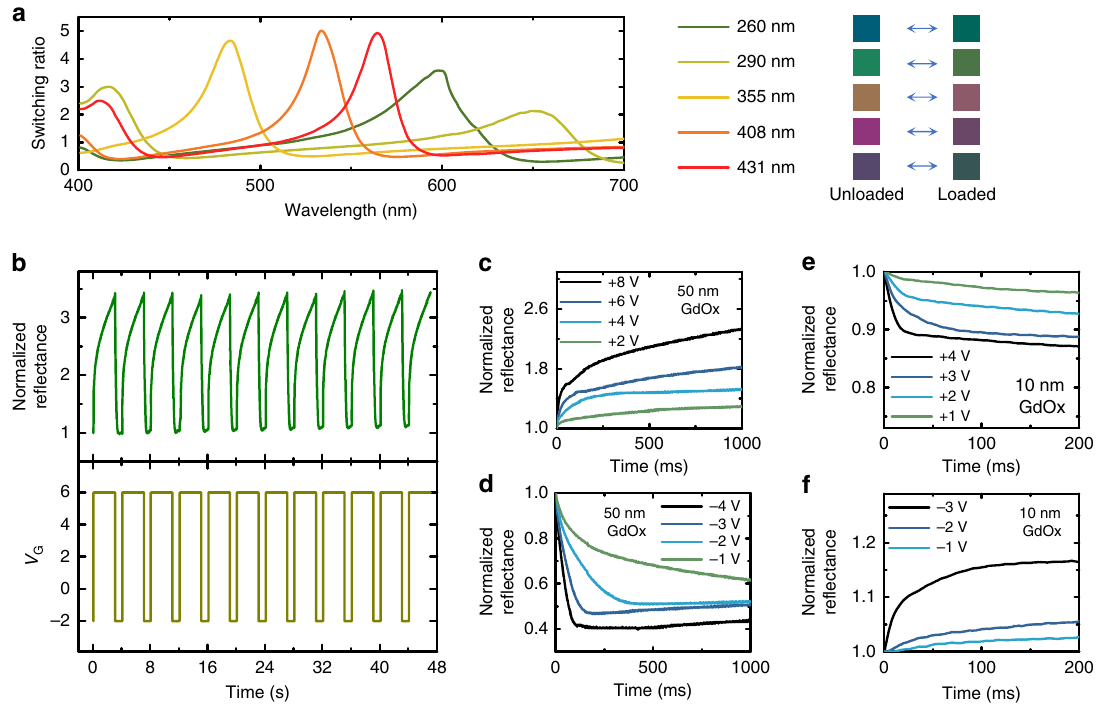
Fig. 4 Switching ratio, reversibility and response time. a Re fl ectance switching ratio versus wavelength for fi ve devices with different SiO 2 thicknesses. The thickness of SiO 2 and the color of the device in both states are shown in the legends. b The normalized re fl ectance of the 408 nm SiO 2 sample measured by a 532 nm laser and V G as a function of time. The re fl ected color can be cycled multiple times reversibly with ratio of ~3. c , d Re fl ectance of the optical device as a function of time measured by a 532 nm laser, showing the switching transient of a device with 50 nm GdO x , switching from V G = − 4 V ( c ) and from V G = + 8 V ( d ) to the voltages labeled on plots. e , f Re fl ectance of the optical device with 10 nm GdO x and 400nm SiO 2 measured by a 660 nm laser as a function of time, switching from V G = − 3 V ( e ) and V G = + 4 V ( f ) to the voltages labeled on the